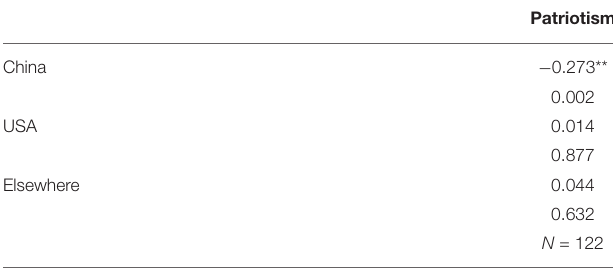
TABLE 4 | Relationship between patriotism and belief about potential origins of COVID-19 among subjects in China.